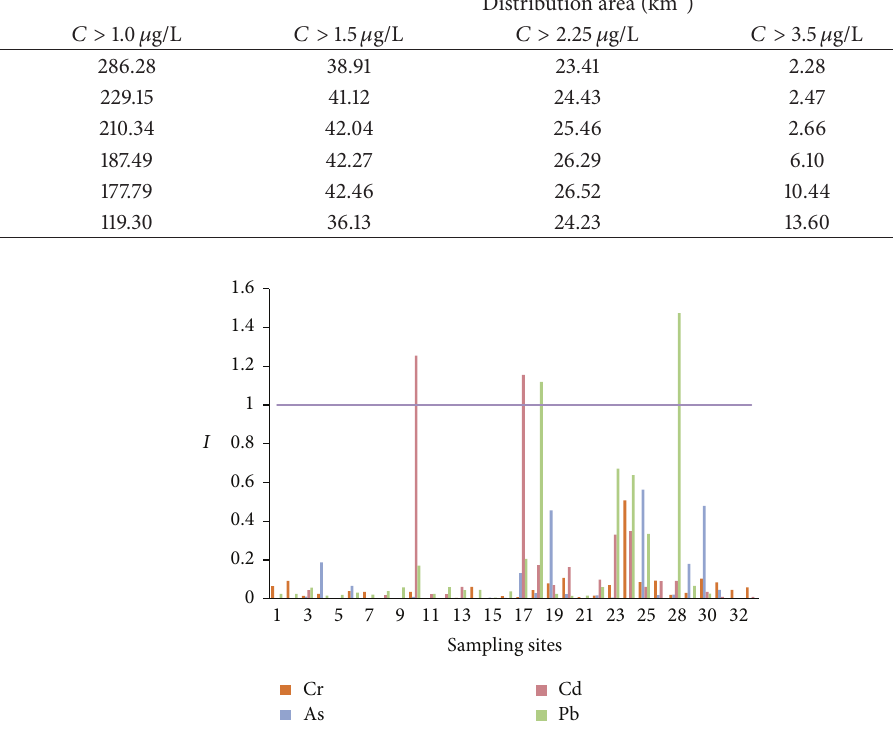
Figure 3: Single-factor pollution indices of heavy metals at all groundwater sampling sites.